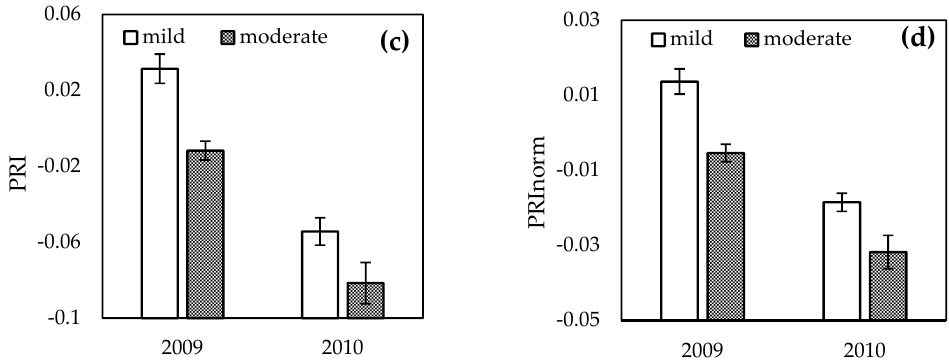
Figure 6. Effects of mild ( Ψ pd > − 0.4 MPa; open bars) and moderate ( Ψ pd < − 0.4 MPa; shaded bars) water deficits on ( a ) water index (WI), ( b ) normalized water index (WI norm ), ( c ) photochemical reflectance index (PRI), and ( d ) normalized photochemical reflectance index (PRI norm ) in Xarel·lo vines. Values are means ± standard errors of the mean ( n = 6 for mild water deficits in 2009 and 2010; n = 8 and n = 7 for moderate water deficits in 2009 and 2010, respectively).